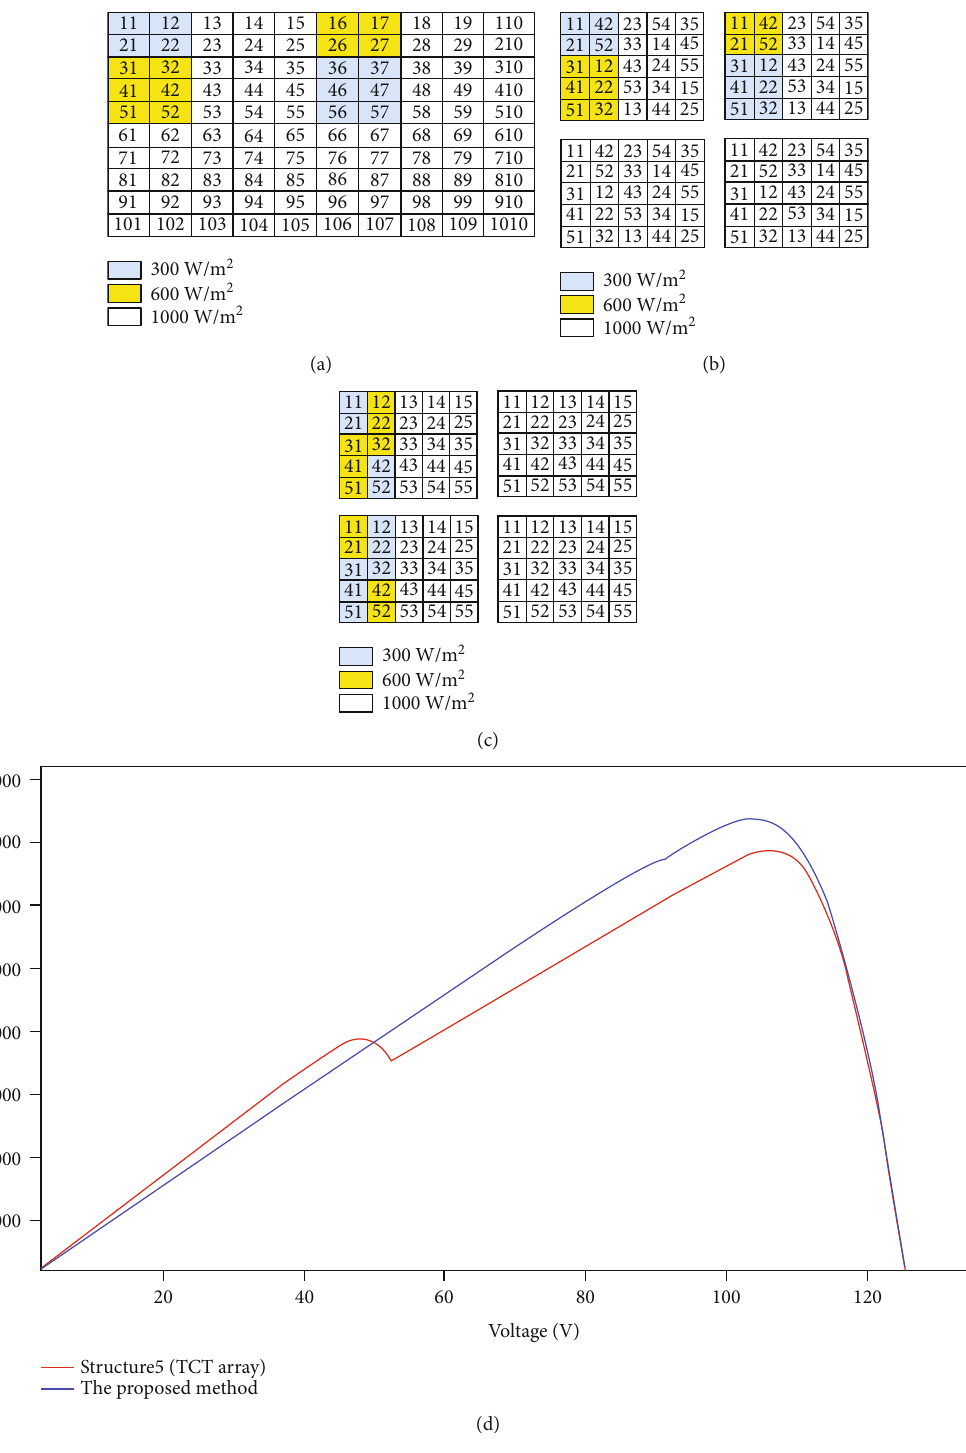
Figure 12: Third shading pattern. (a) TCT array. (b) The proposed method before recon fi guration. (c) The proposed method after recon fi guration. (d) The PV array characteristics for the TCT array and the proposed